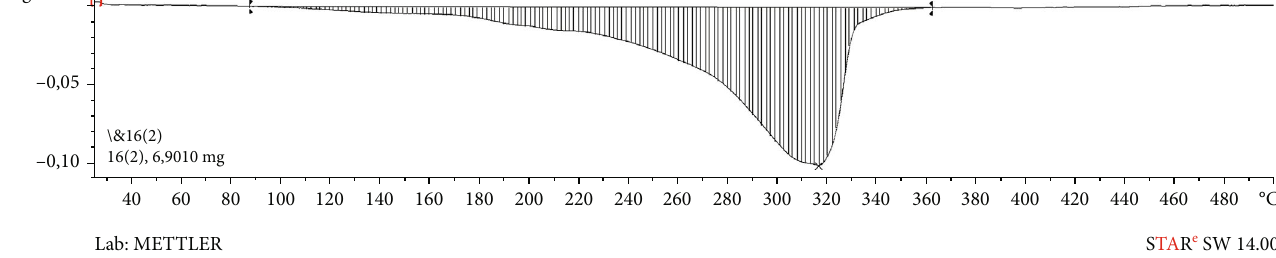
Figure 2: DTG curve of the plasticizer of DPEA.